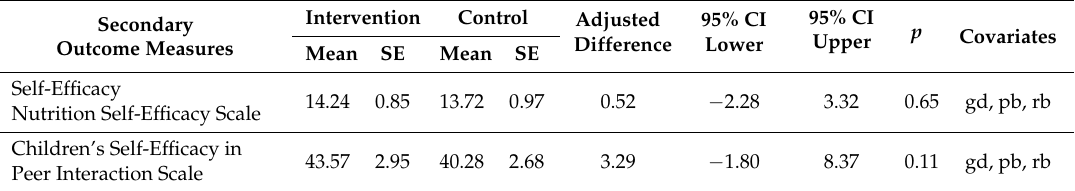
Table 4. Estimates of self-efficacy in complex sample general linear model.